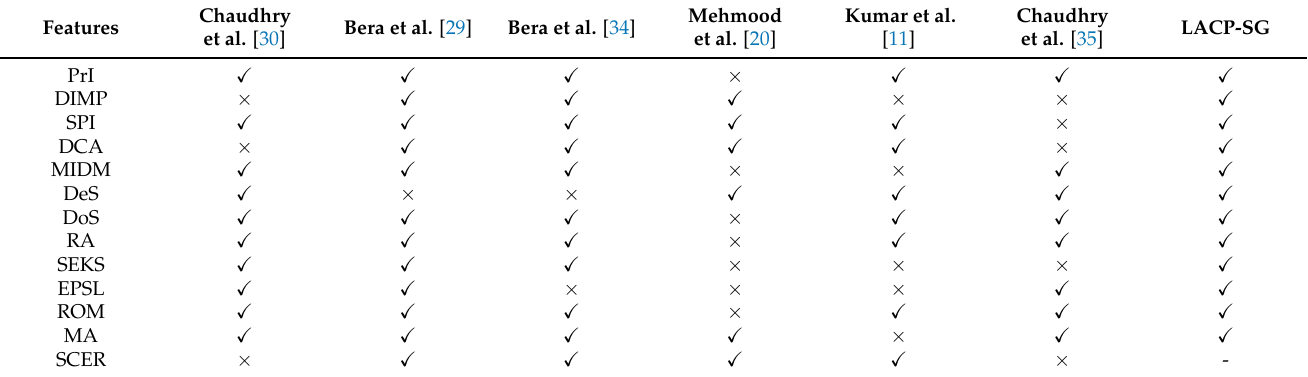
Table 5. Security